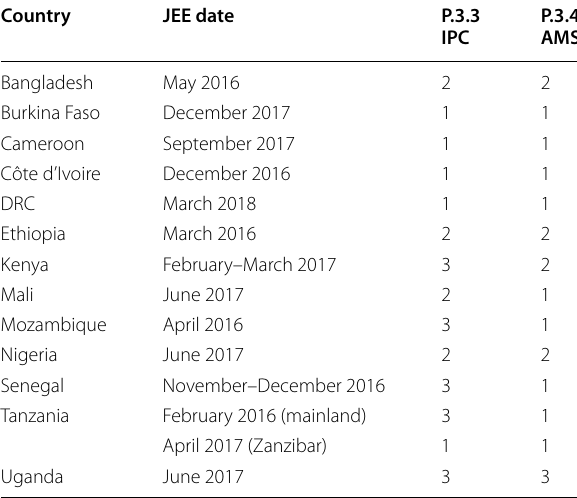
Table 2 Collaborating countries receiving GHSA support on AMR containment through the program